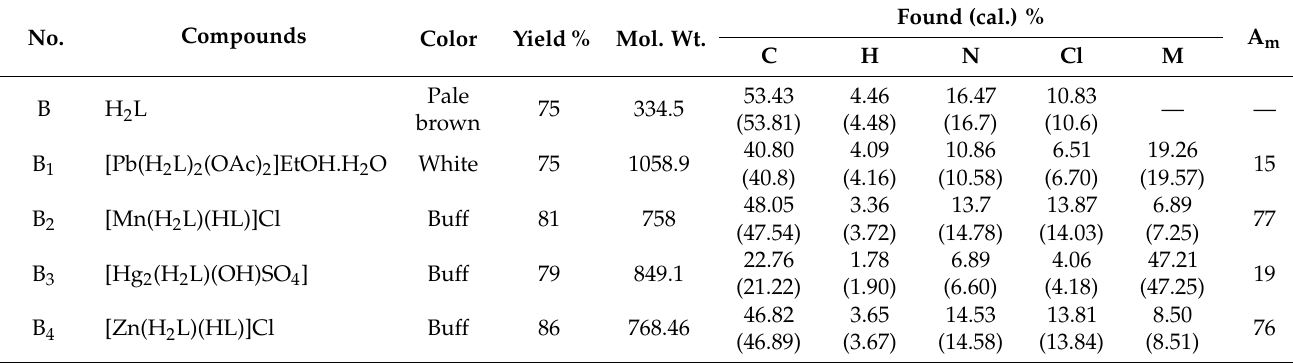
Table 1. Analytical data of the ligand (H 2 L) and its metal complexes.